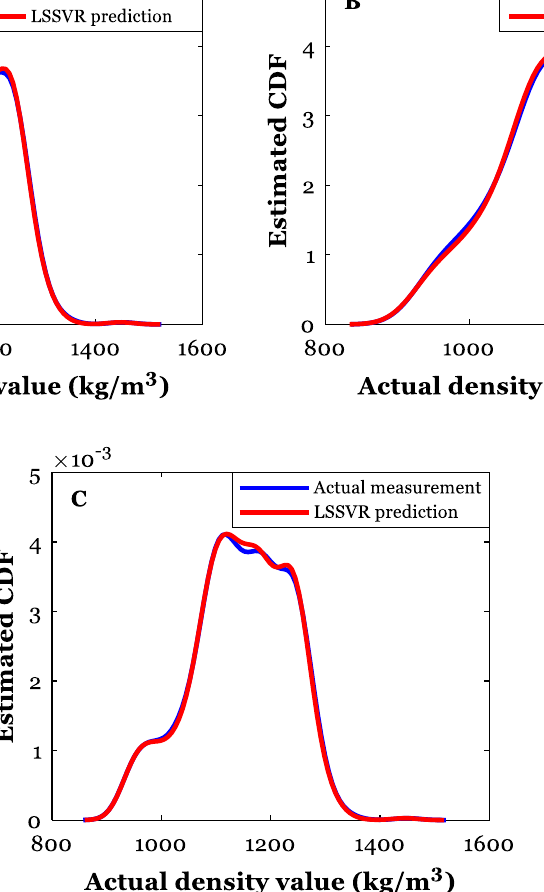
Figure 4. Utilizing the kernel density estimation method to check the LSSVR validity in the training ( A ) and testing ( B ) stages and against whole the databank ( C